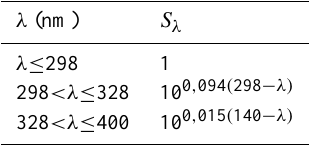
Table 1. CIE action spectrum for